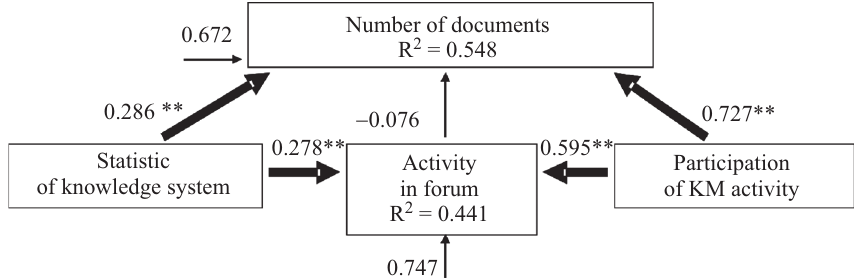
Fig. 4. The path analysis diagram, *P < 0.05, **p <